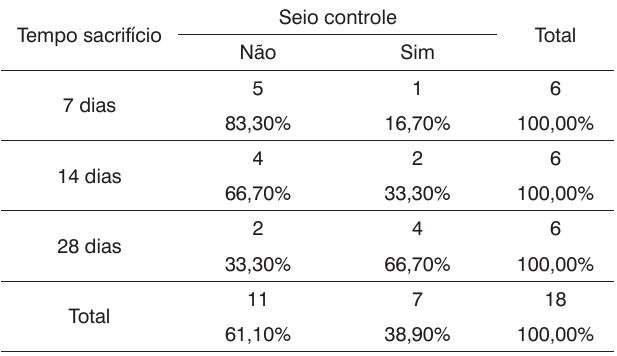
Tabela 5. Padrão Inflamatório nos seios controles conforme o tempo de sacrifício.